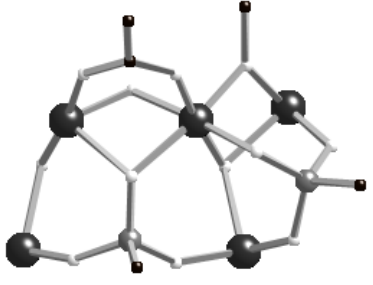
Figure 3. Fragment of structure of 6 highlighting the phosphonate binding modes. The top three vanadium ions are in the “upper” V 8